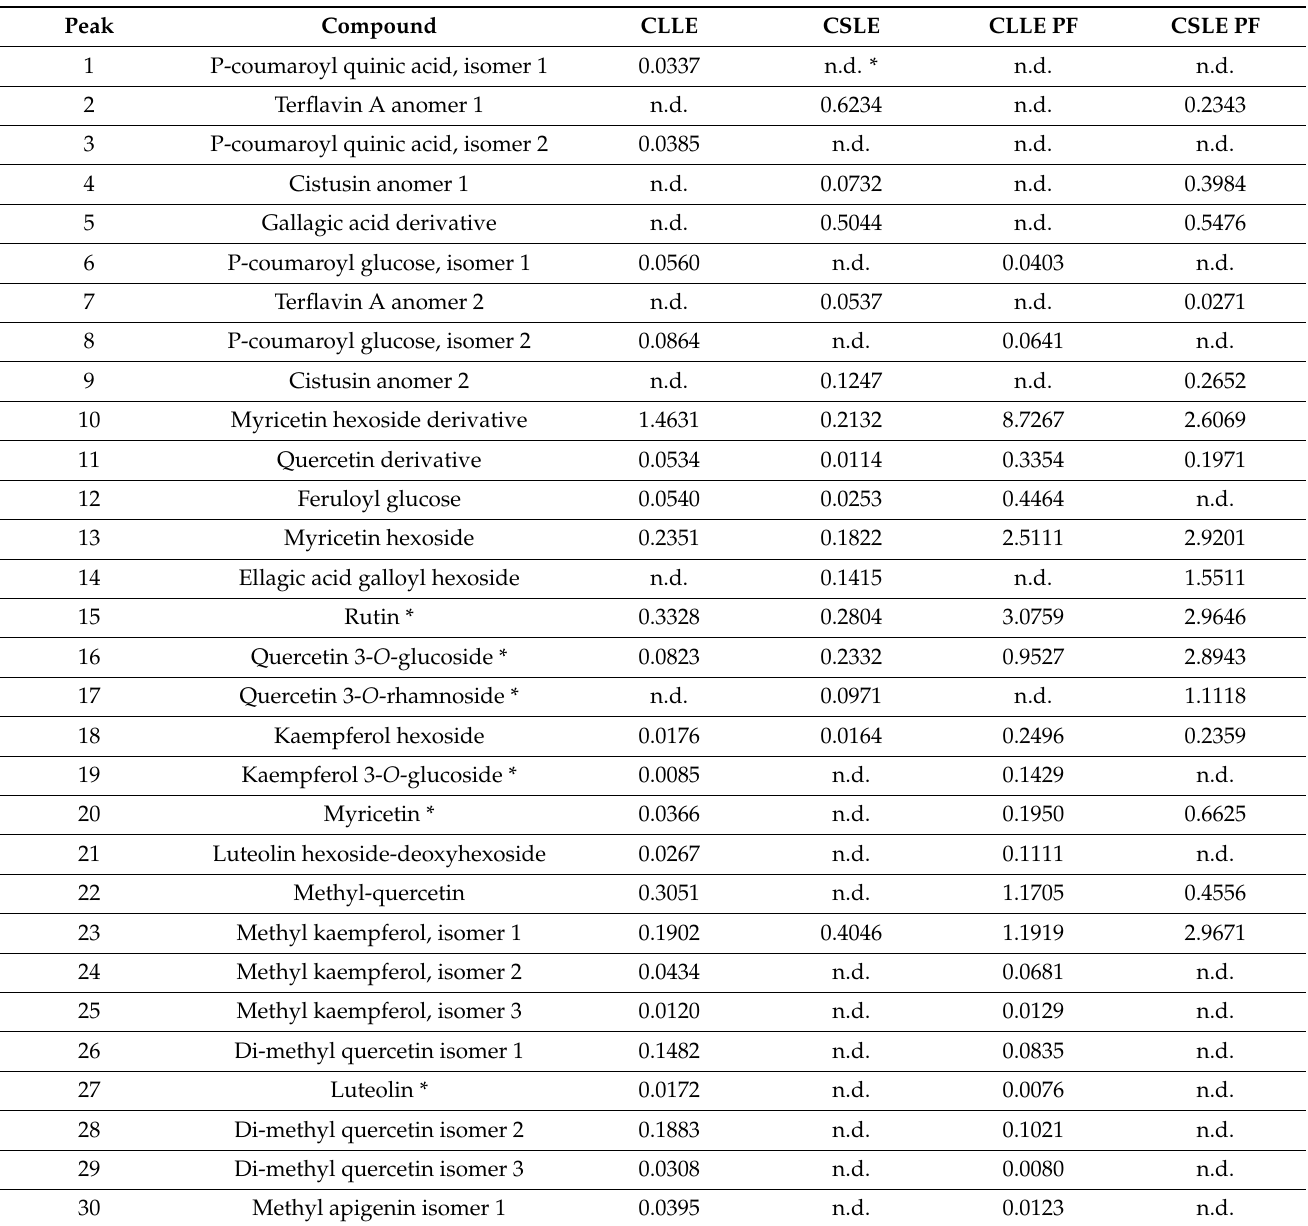
Table 2. Content of individual metabolites from the Cistus spp. extracts object of this study, reported in mg over 100 g of